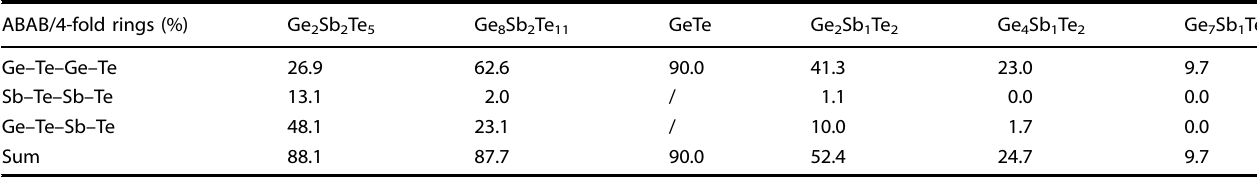
Table 1. The statistics of ABAB rings for the six alloys characterized in Fig. 3. ABAB/4-fold rings (%)